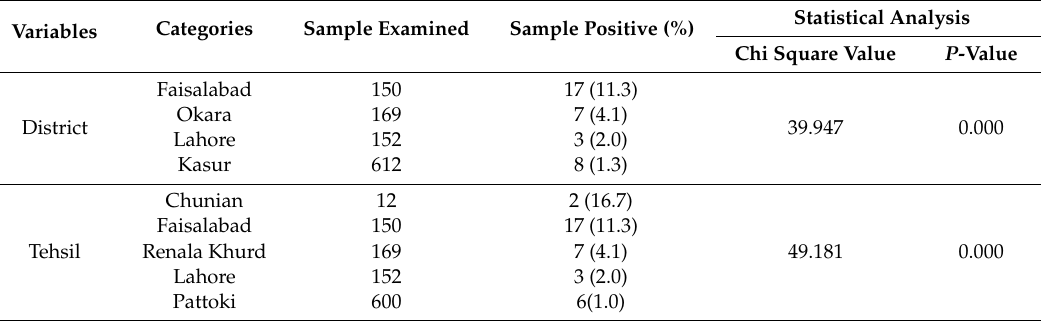
Table 2. District and tehsil-wise seroprevalence of